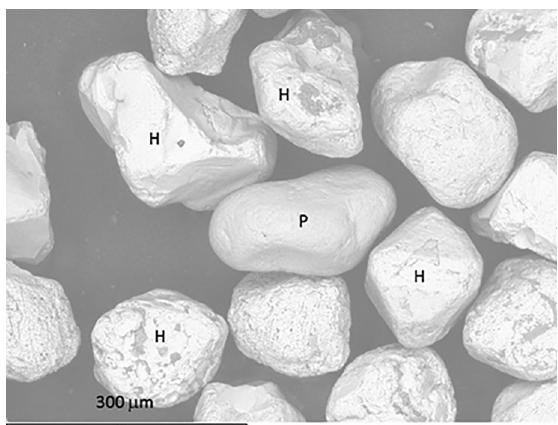
Fig. 5. A scanning electron microscope photo of the hematite fraction separated using a magnet. The letters mark the measuring points (H for hematite and P for assumed pseudo-